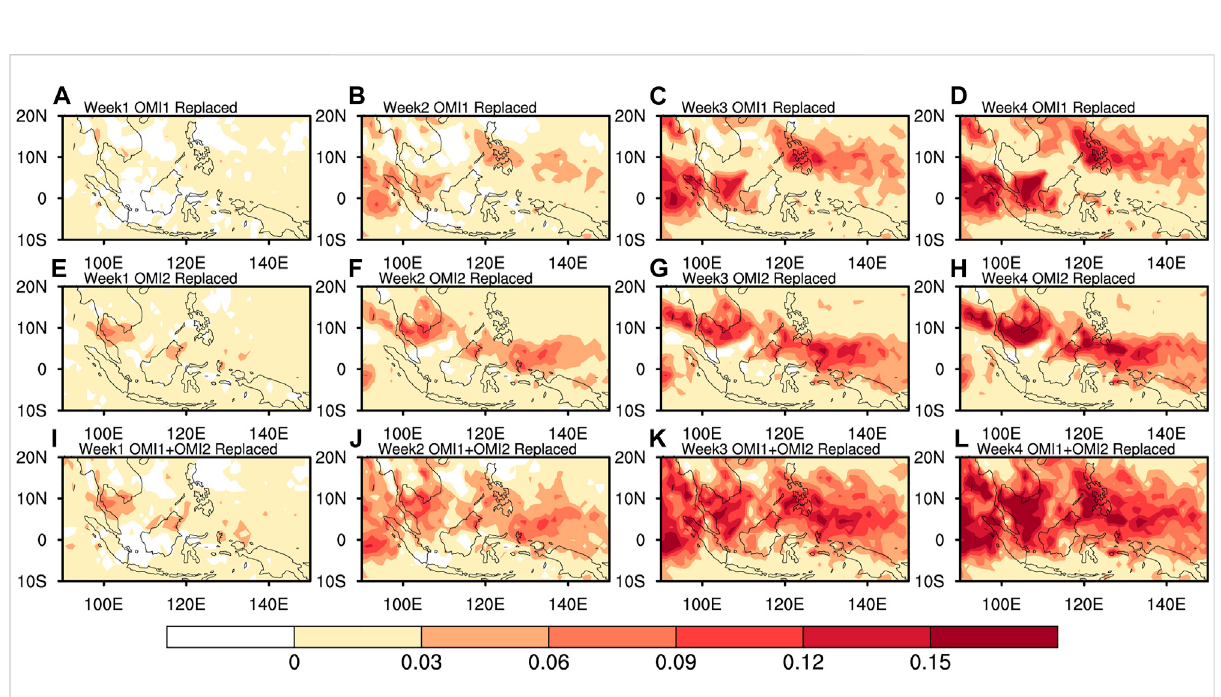
drivers of ENSO, OMI1, OMI2, and OMI1+OMI2 with the observed regression patterns for ECMWF and CMA, respectively. The linear regression approach is used to obtain ENSO, OMI1 and OMI2 related precipitation variabilities for both forecasts and observations. To be speci fi c, the predicted